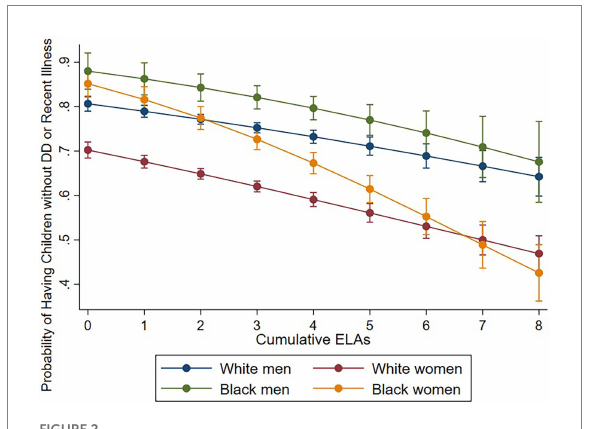
FIGURE 2 Cumulative Early-Life Adversities (ELAs) and Probability of having Children without DD and without Recent Illness. Figure is based on two logistic regressions which regressed parenting type [children without Developmentally Disabled (DD) and with recent chronic illness vs. the rest] on the interaction between the cumulative ELAs and race–gender groups, controlling for age and